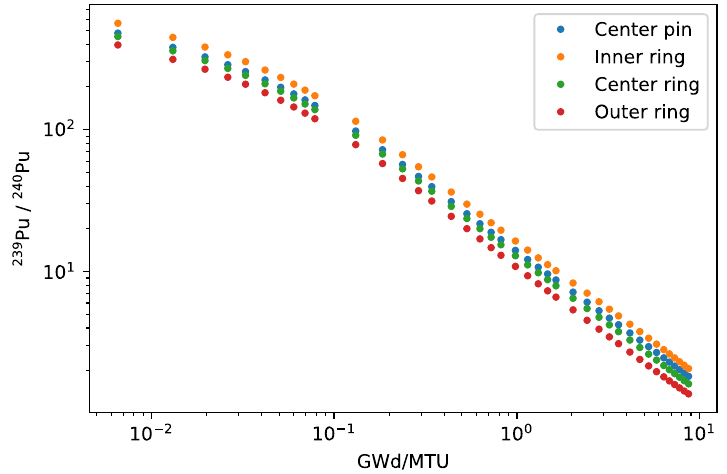
Figure 4: Single Bundle Burnup Analysis of 239 Pu/ 240